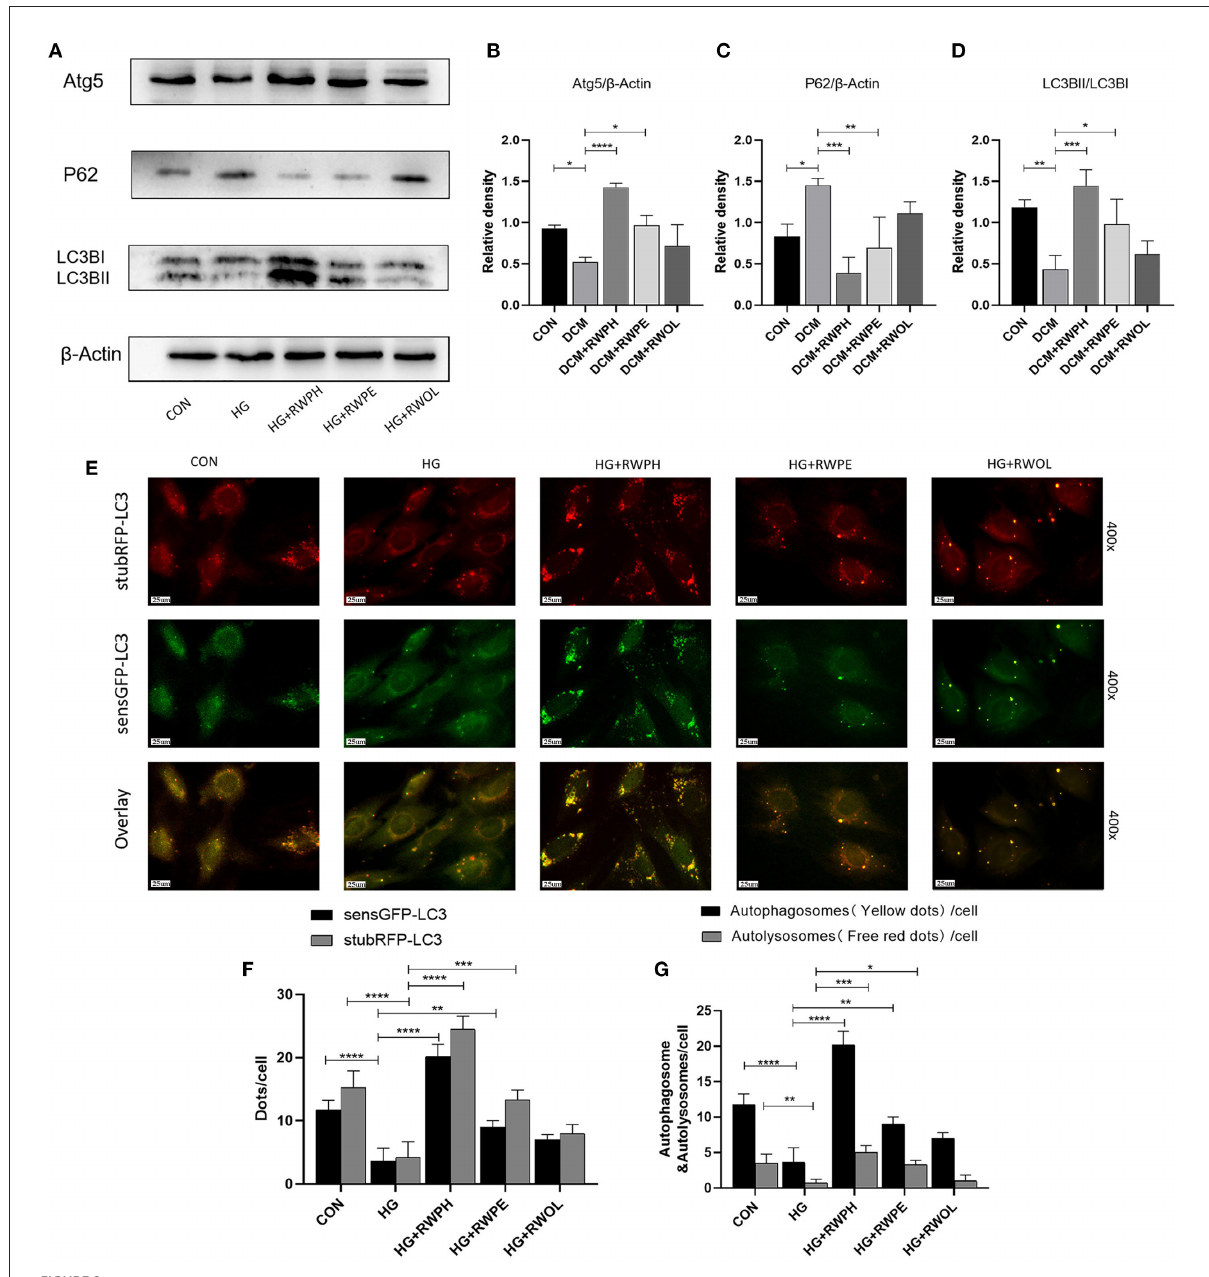
FIGURE2 RWPH and RWPE rescue impaired autophagy in high-glucose cultured H9C2 cells. (A–D) Western blot analysis of the relative protein expression of ATG5, P62, and LC3B in H9C2 cells. (E–G) stubRFP-sensGFP-LC3 fluorescence was used to determine the autophagic activity in HG group and treatment groups. GFP fluorescence represents autophagosomes, RFP fluorescence represents autophagosomes and autolysosomes, the two merged to form yellow dots represent autophagosomes, and the remaining red dots represent autolysosomes. * P < 0.05, ** P < 0.01, *** P < 0.001, and **** P <